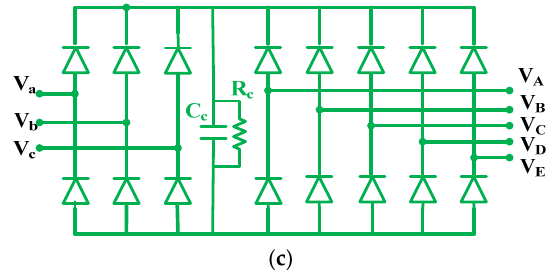
Figure 1. ( a ) DMC, ( b ) IMC and ( c ) conventional clamping